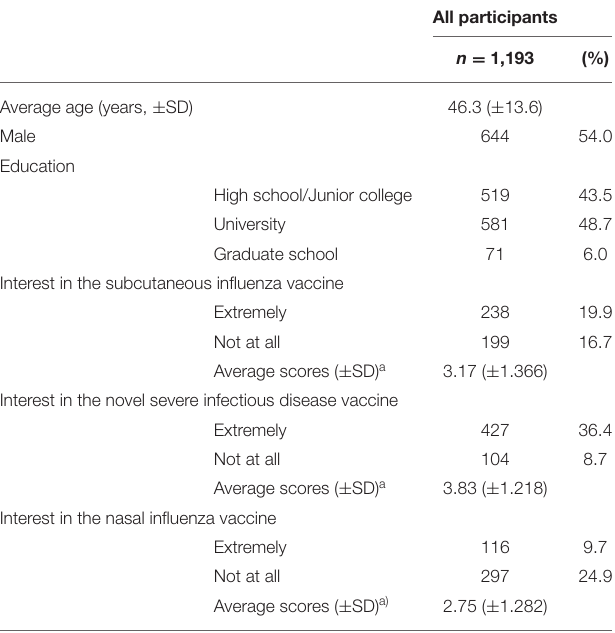
TABLE 1 | Characteristics and interest in the